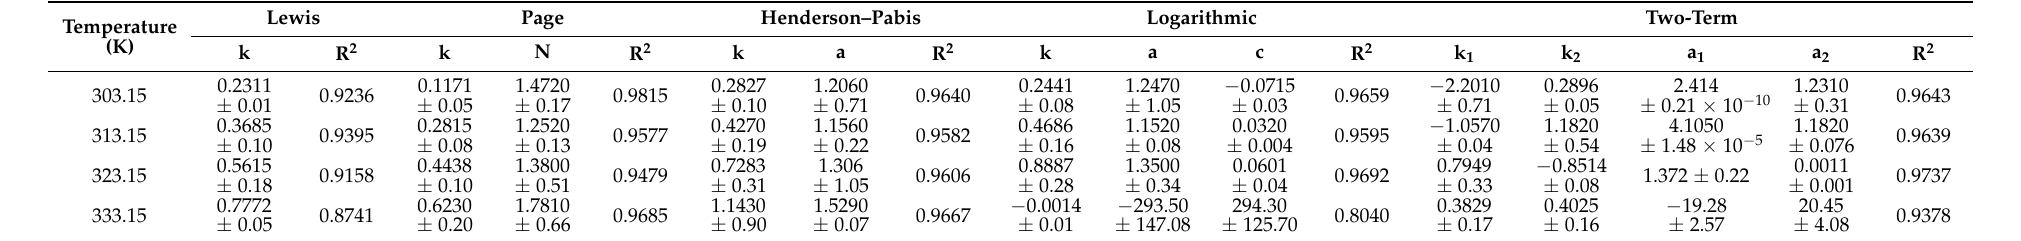
Table 2. Kinetic parameters and coefficient of determination (R 2 ) of the drying models for Kyoho skin 1 .